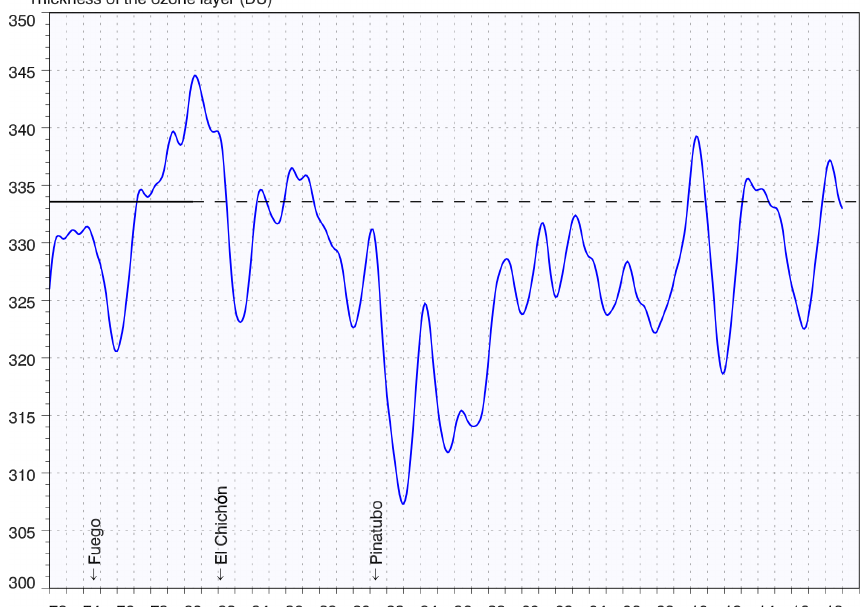
Figure A1. Evolution of the total ozone column at Uccle as observed with Dobson D40 (1972–1989), Brewer no. 16 (1990–2001), and Brewer no. 178 (2002–present). The solid horizontal black line marks the 1972–1980 total ozone average (period before catalytic ozone loss), extended until the end of the time series by the dashed horizontal line. The periods of major volcanic eruptions affecting the ozone layer are indicated on the time axis as